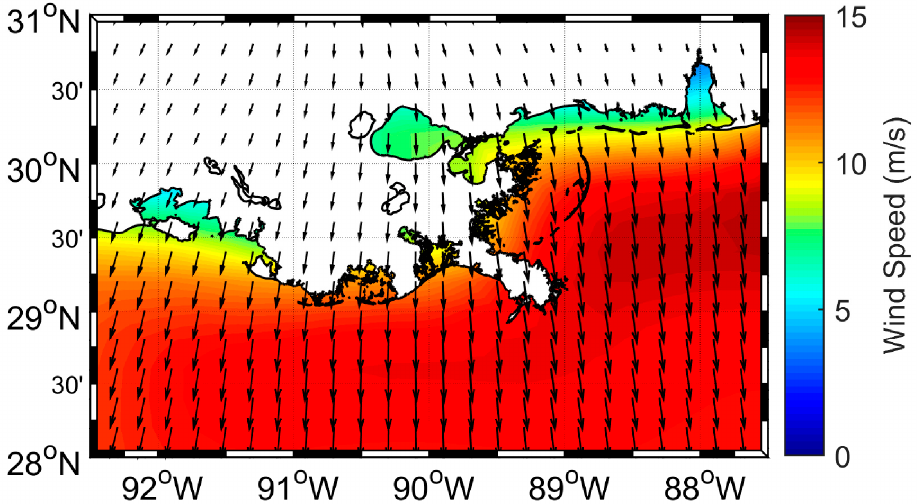
Figure 4. A sample of CFSR wind filed during the peak of cold front no.2 over the Louisiana shelf.